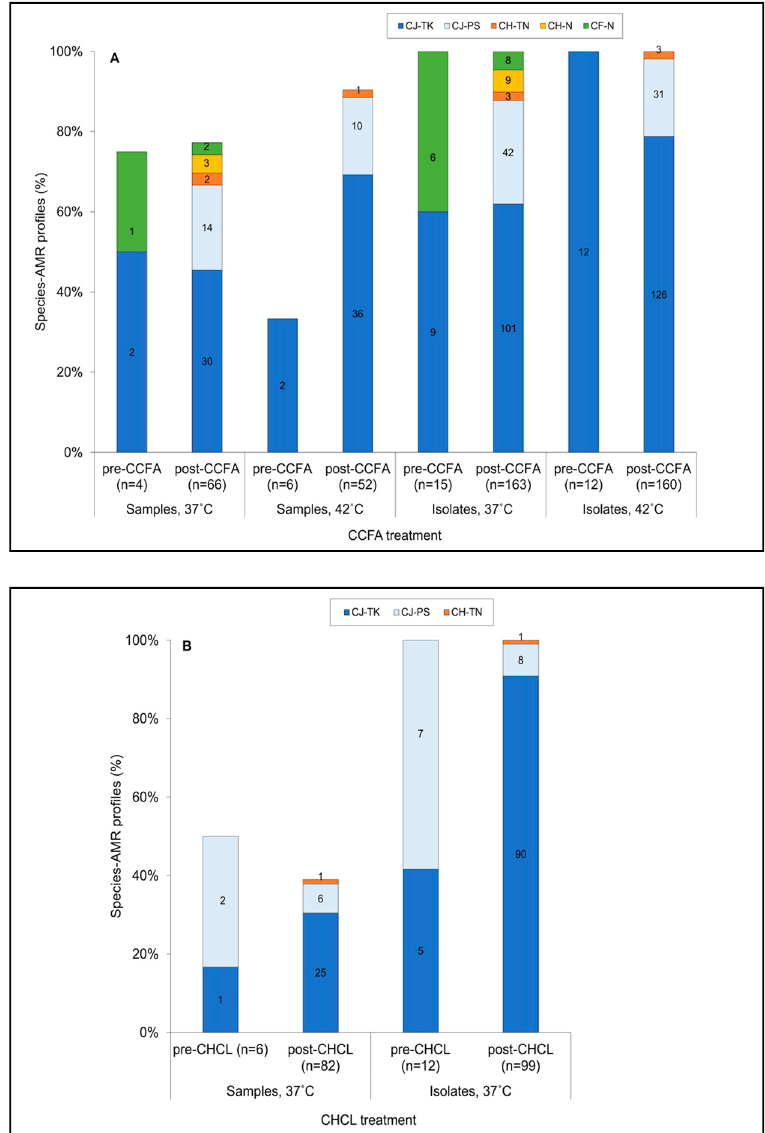
Figure 4. Prevalence of different species and antimicrobial resistance (AMR) profiles in Campylobacter samples and isolates from ( A ) CCFA and ( B ) CHCL groups. Species-AMR combinations are as in inset where CJ, CH, and CF indicate C. jejuni , C. hyointestinalis , and C. fetus , respectively. AMR abbreviations: TK, resistance only to tetracycline and kanamycin; PS, pan-susceptible; TN, resistance only to tetracycline and nalidixic acid; N, resistance only to nalidixic acid. Pre-CHCL or - CCFA referred to 0 h, while post-CHCL or -CCFA was a compilation of all sampling points after 0 h. A total of 12 samples from CCFA (seven at 37 °C and five at 42 °C, all post-treatment) and six from CHCL (post-treatment) yielded both C. jejuni TK and C. jejuni PS. “Samples” and “Isolates” are defined as described in the legend of Figure 1. Campylobacter detection from the fecal samples and determination of species and AMR profiles were as described in the Materials and Methods.